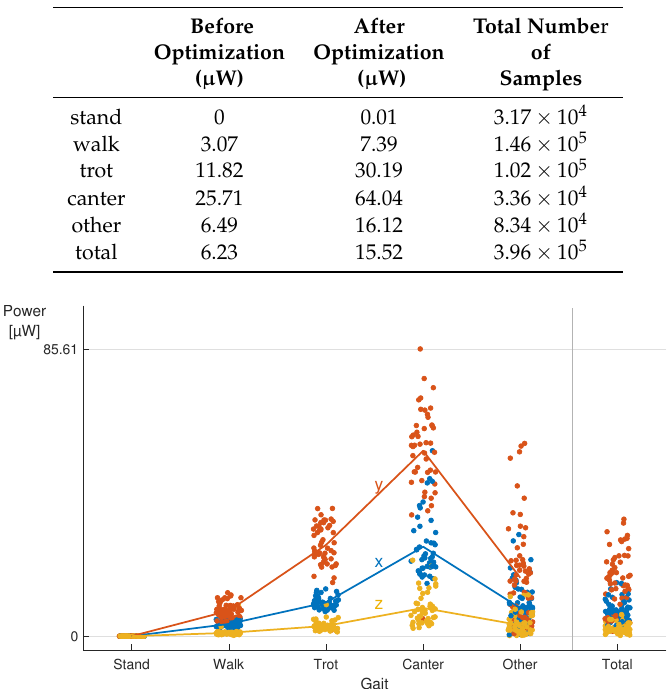
Figure 9. The harvested power with optimal parameters ( µ W), for the x (blue), y (orange) and z (yellow) axis. Canter is the most profitable gait, the y-direction is the best suited orientation with most possibilities. The best dataset could reach an average of 85.61 µ W during canter, although a lot of difference between the energy levels of canter in the different datasets has to be noticed.